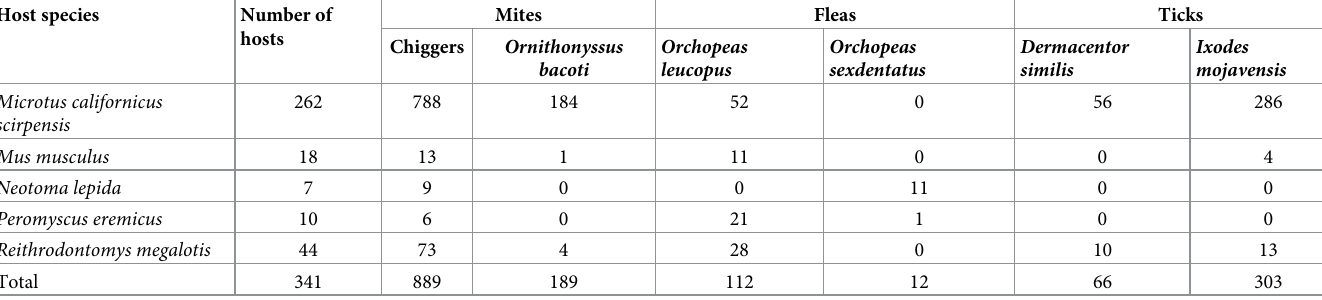
Table 1. Number of ectoparasites collected from rodents from 11 marshes in Tecopa, California, US between 2011 and 2019. Host